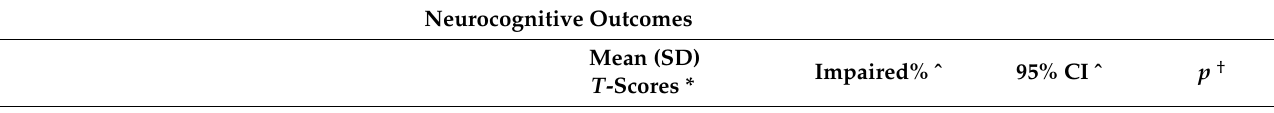
Table 2. Neurocognitive